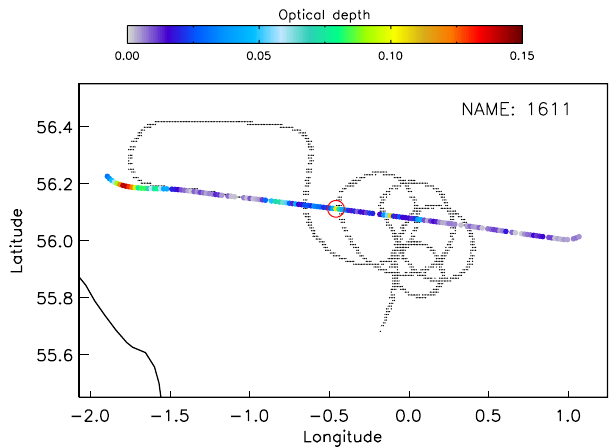
Fig. 5. Lidar-derived optical depth is shown by the colour variation (colour bar at top of figure) of the track going from east to west. The SLR passes over the previous orbits as indicated by the NAME data (dashed black line), where this is the output for 16:11 and the circle indicates the corresponding point on the SLR for this